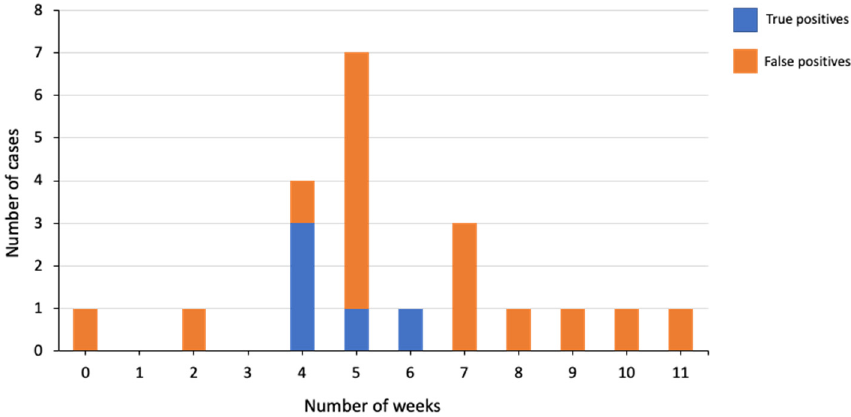
Figure 1. Relationship between the length of time from fetal demise diagnosis to NIPT and true- positive and false-positive calls.